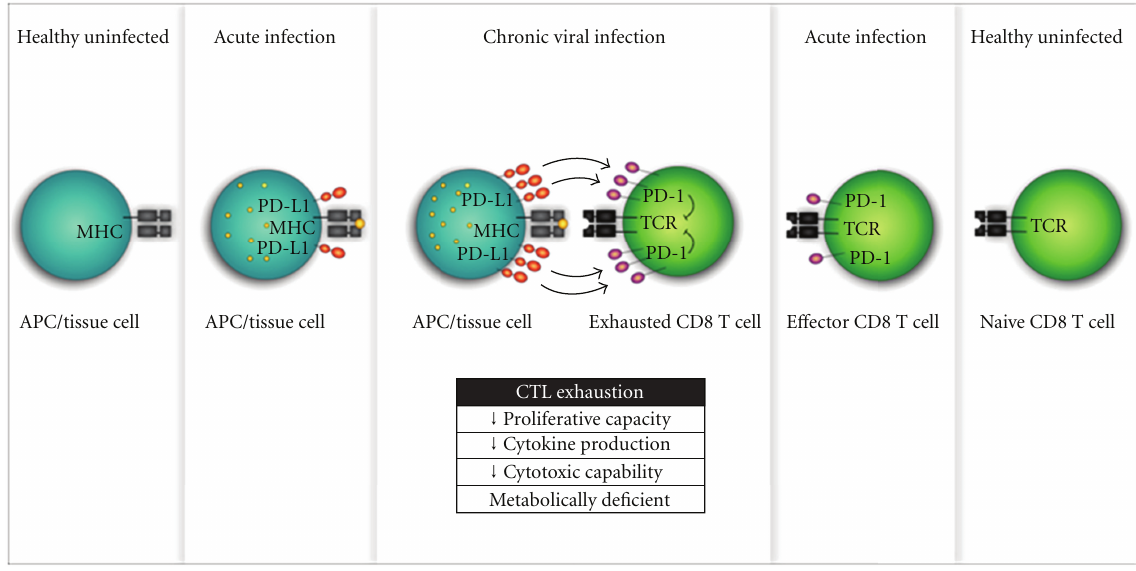
Figure 1: PD-1/PD-L1-mediated cytotoxic T lymphocyte exhaustion during chronic viral infection. During chronic viral infection, the persistent presentation of antigen causes CD8 T cells to highly upregulate PD-1, a T cell coinhibitory receptor. PD-L1, the ligand for PD-1, is also upregulated on APC or resident tissue cells during chronic viral infection. This severe overrepresentation of the inhibitory PD-1/PD-L1 pathway is a major cause of exhaustion in CD8 T cells. Exhausted CD8 T cells are functionally deficient and have decreased proliferative capacity, cytokine production, and cytotoxic capacity and are metabolically deficient. Exhausted CD8 T cells are ine ff ective at clearing virus and, in turn, the chronic infection